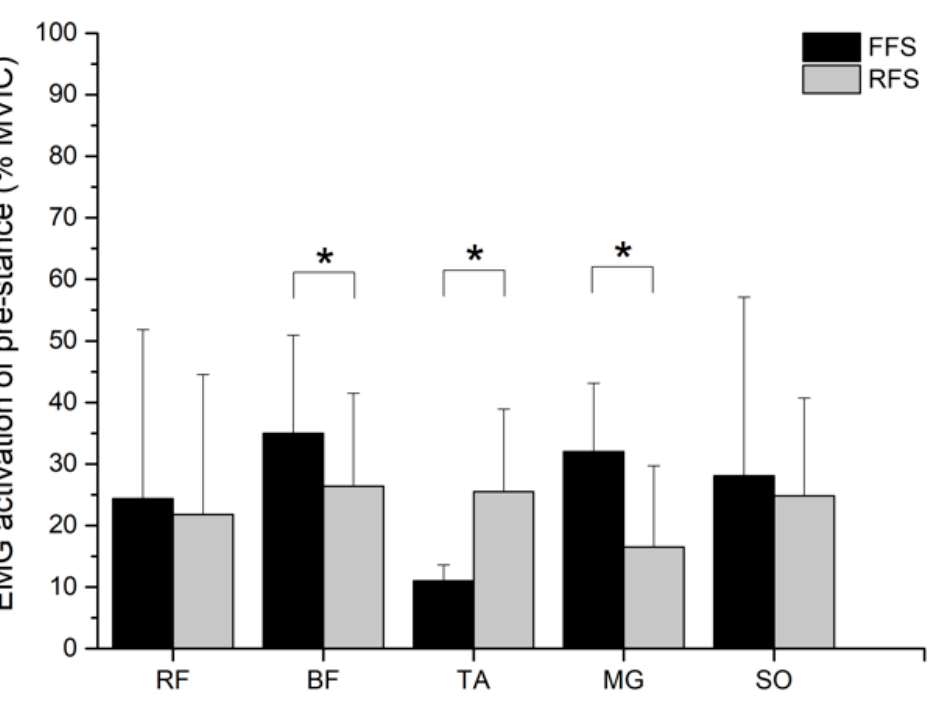
Figure 5. Muscle activity of FFS and RFS pattern during the pre-stance phase. Note: * indicates p < 0.05; FFS = forefoot strike pattern; RFS = rearfoot strike pattern; RF = rectus femoris; BF = biceps femoris; TA = tibialis anterior; GM = gastrocnemius medialis; SO = soleus.